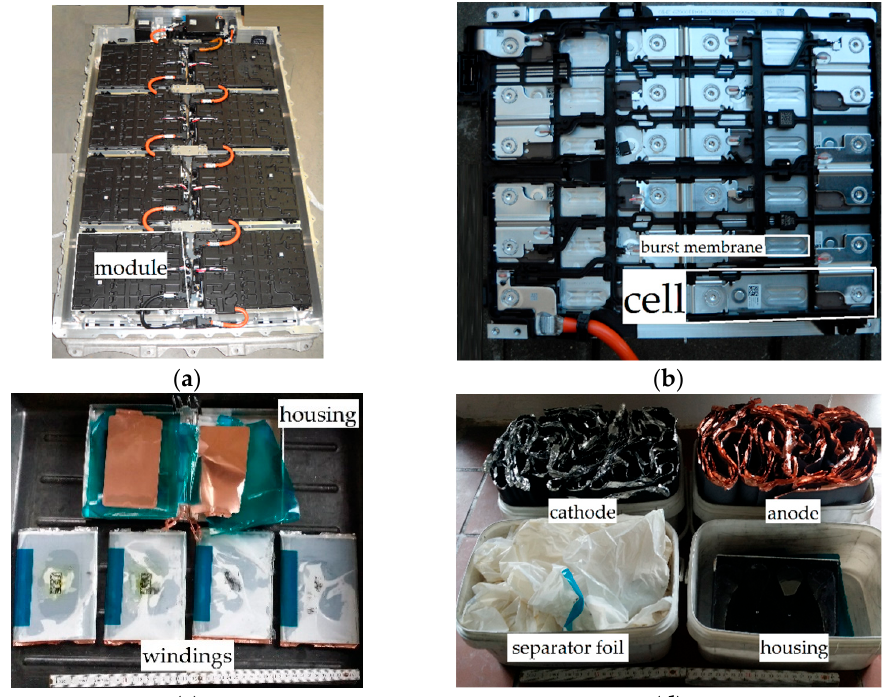
Figure 4. Dismantling steps: ( a ) system with 8 modules; ( b ) module with 12 cells and highlighted burst membrane; ( c ) functional unit with open-bended cell housing containing 4 windings; ( d ) elec- trode with closed cell housing, cathode, anode and separator foil from 4 windings.